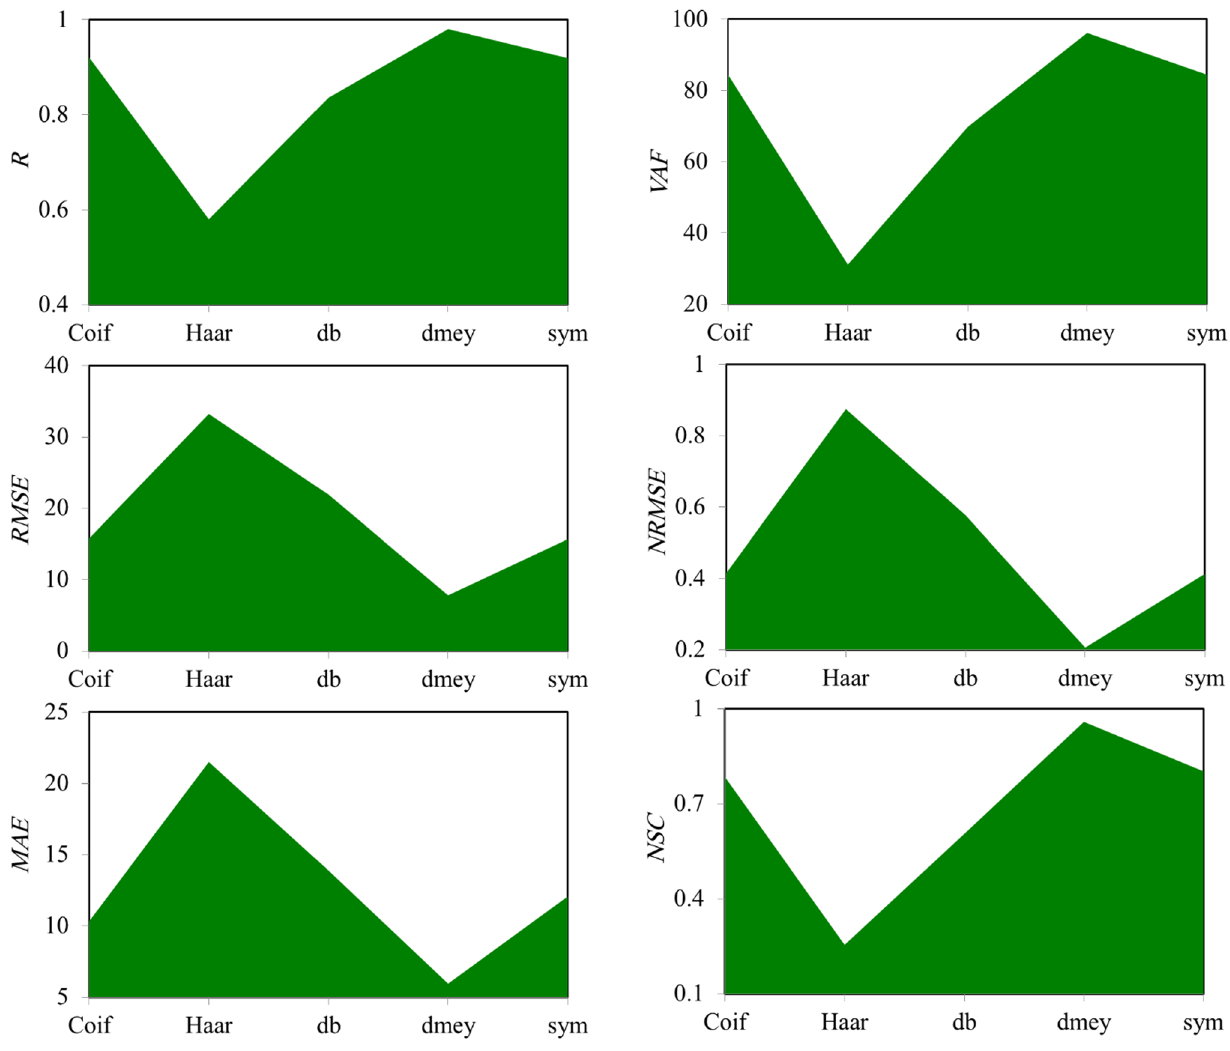
Fig. 5 Estimations of statistical indices for the superior members of different wavelet